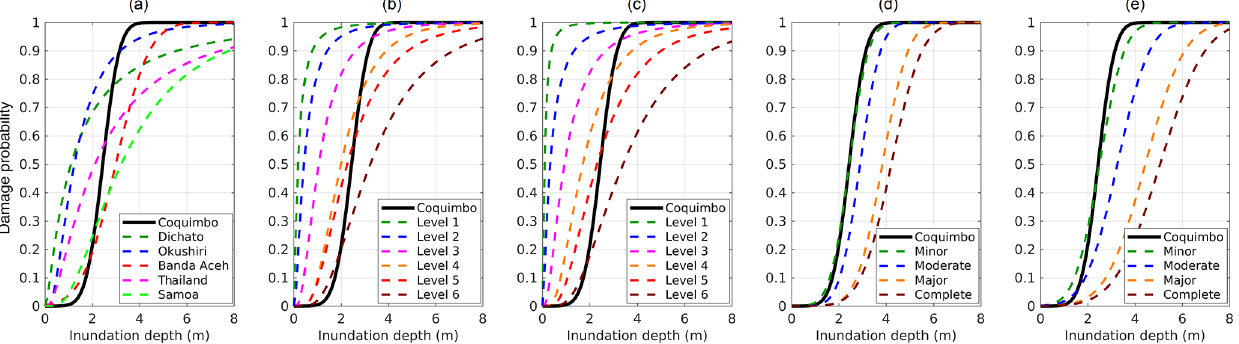
Figure 9. Tsunami fragility curves for damage probability developed for other locations and different damage levels. (a) Two levels of damage obtained for three different cities in Chile, Japan and Indonesia. (b) Six damage levels for wooden structures given by Suppasri et al. (2013). (c) Six damage levels for mixed-material structures by Suppasri et al. (2013). (d) Four damage levels for wooden houses given by Suppasri et al. (2012b). (e) Four damage levels for mixed-material structures given by Suppasri et al.